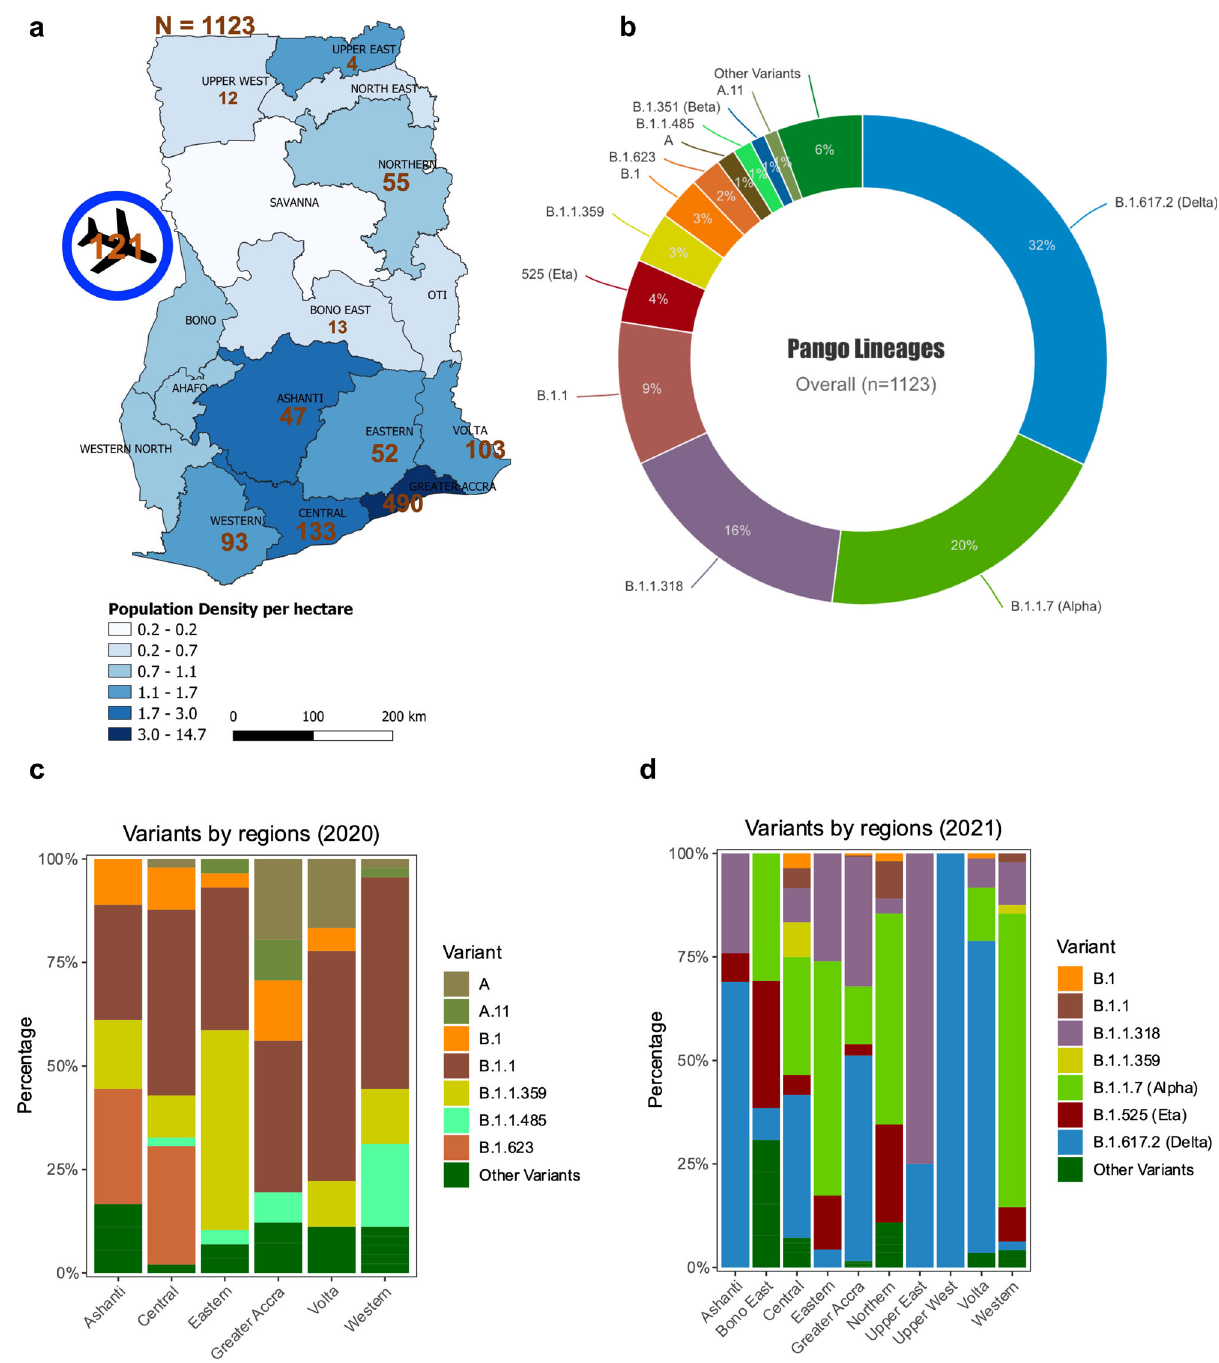
Fig. 1 Overall genomic epidemiology of the circulating variants across various regions in Ghana ( N = 1123). a Map showing the ten sampled regions ( n = 1002) and travellers arriving in the country (121) at the Kotoka International Airport in the Greater Accra Region. The colour scheme shows the population density per hectare in each region, while the numbers are samples sequenced per region. b Overall SARS-CoV-2 lineages in Ghana for both local participants and travellers ( n = 1123); the lineages are represented by different colours, while the percentages represent the proportion of cases with that particular lineage out of 1123 participants. Lineages with <6 participants are represented as “ Other Variants ” . c Out of the 1002 samples sequenced from community samples, 200 samples were sequenced in 2020 and 802 samples sequenced in 2021. The stacked plot shows the percentage distribution of lineages in six regions in 2020. Lineages are represented in unique colours as indicated on the plots. d The stacked plot shows the percentage distribution of lineages in 2021 from ten regions across Ghana ( n =